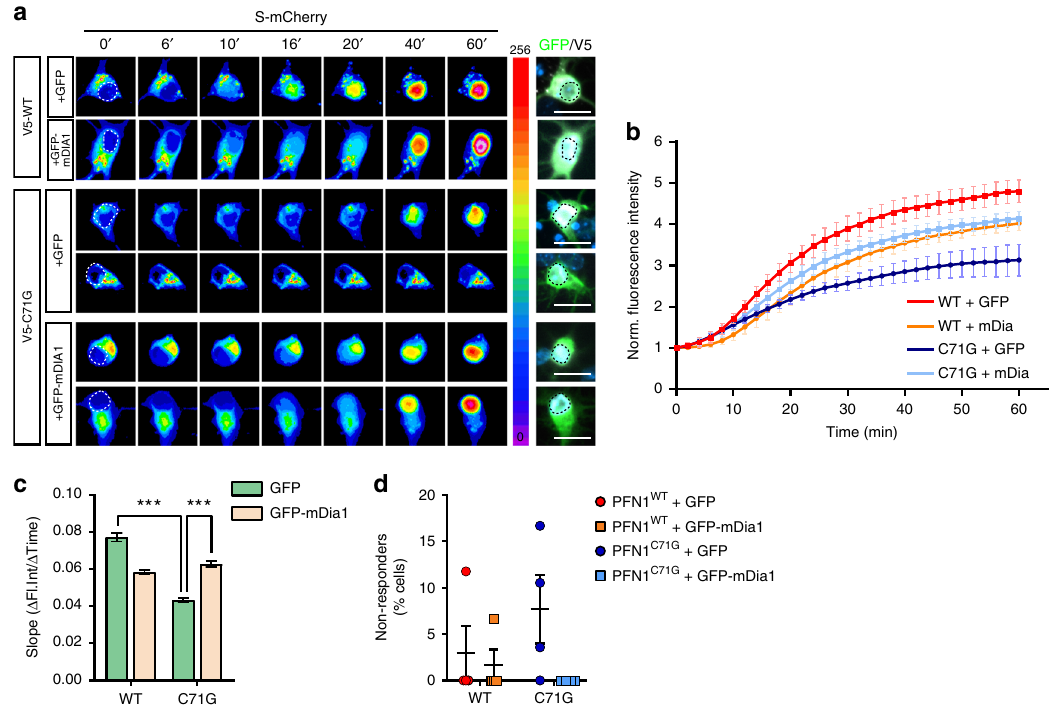
Fig. 8 Formin mDia1 overexpression rescues nuclear import defects. a , b Time-lapse images and quanti fi cation of S-mCherry nuclear import dynamics upon treatment with LMB in cortical neurons expressing GFP or GFP-mDia1 (green) and V5-tagged PFN1 (white). S-mCherry levels are shown as 16-bit heat map. Dashed lines indicate the nucleus. Cells were post- fi xed and stained to verify the expression of V5-PFN1 constructs (white). c , d Regression analysis of S- mCherry nuclear import kinetics ( c ) and percentage of non-responder cells ( d ). DAPI (blue) was used to detect the nucleus and assess cell health. Scale bars: 10 µ m. Bars are mean± SEM. *** p <0.001. N = 43 – 50 cells from 4 independent experiments. See also Supplementary Table 1 for details on